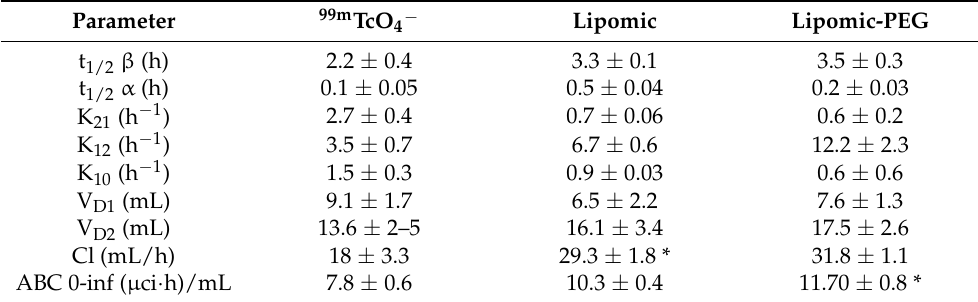
The data correspond to the average (n = 5) ± standard deviation. (*) indicates a statistically significant difference from the other groups. High 99m TcO − and lipomics concentrations were observed in the peripheral compart- ment when comparing the volumes of distribution of compartments 1 and 2 (V D1 and V D2 ), where it was shown that V D2 was greater than that shown by V D1 with “free” 99m TcO − being the most frequently captured by the peripheral compartment and in turn the